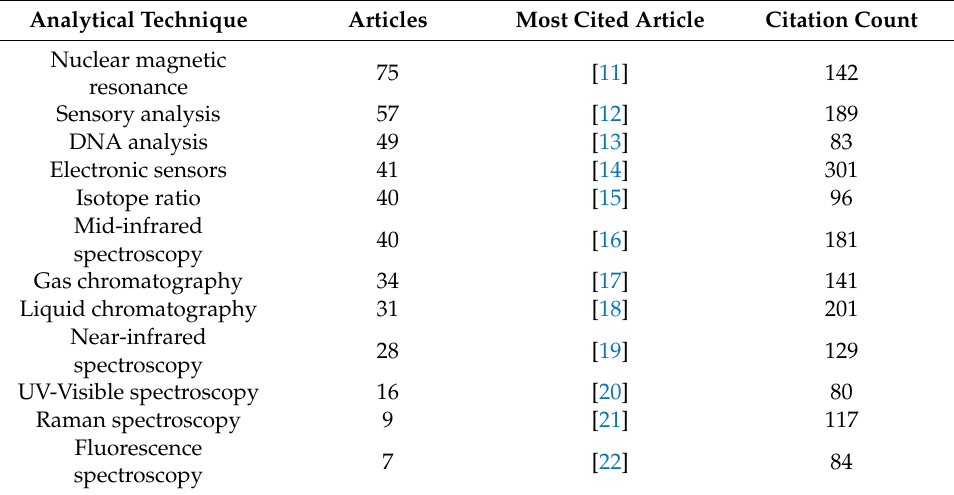
Table 1. Number of articles containing keywords related to specific analytical techniques and most cited article for each technique, with citation count up to 2018.